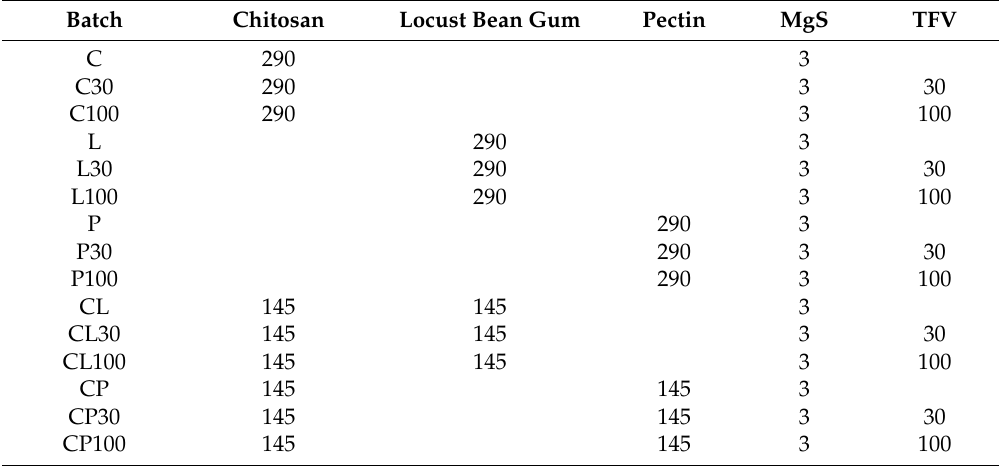
Table 1. Composition of the batches prepared in